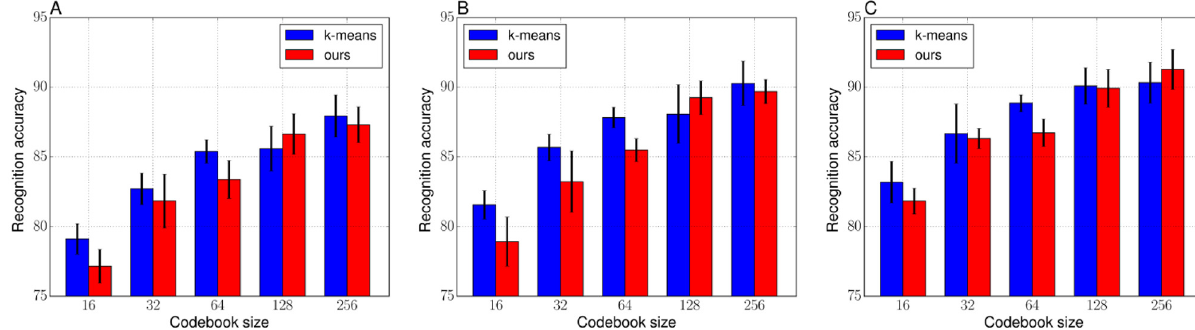
Fig 6. Recognition accuracies of the VLADs with the k-means and ours (hard objective) codebooks on the Butterflies. (A) 20 images per category for training. (B) 30 images per category for training. (C) 40 images per category for training.